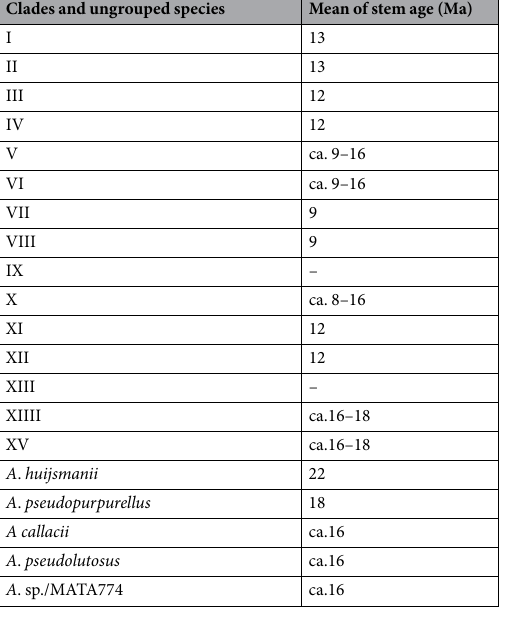
Table 1. Mean of stem ages of clades and ungrouped species from section Minores